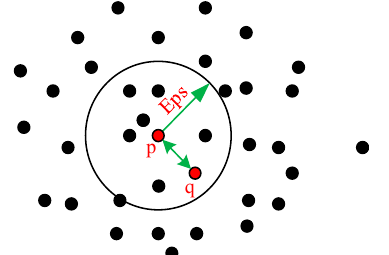
Figure 2. Definition of direct density-reachable.